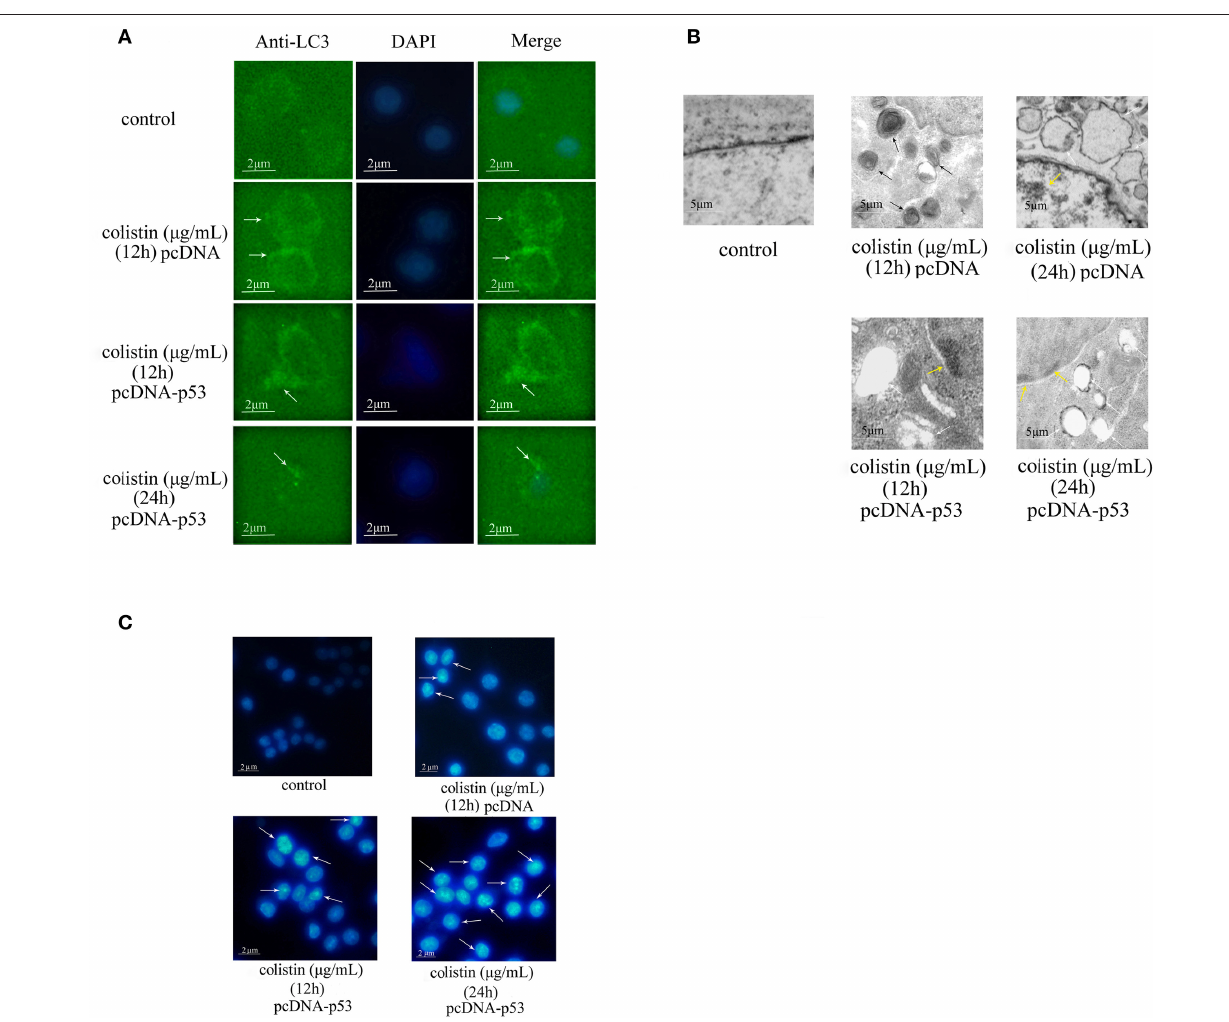
cytoplasm rather than in the nucleus. These results provide